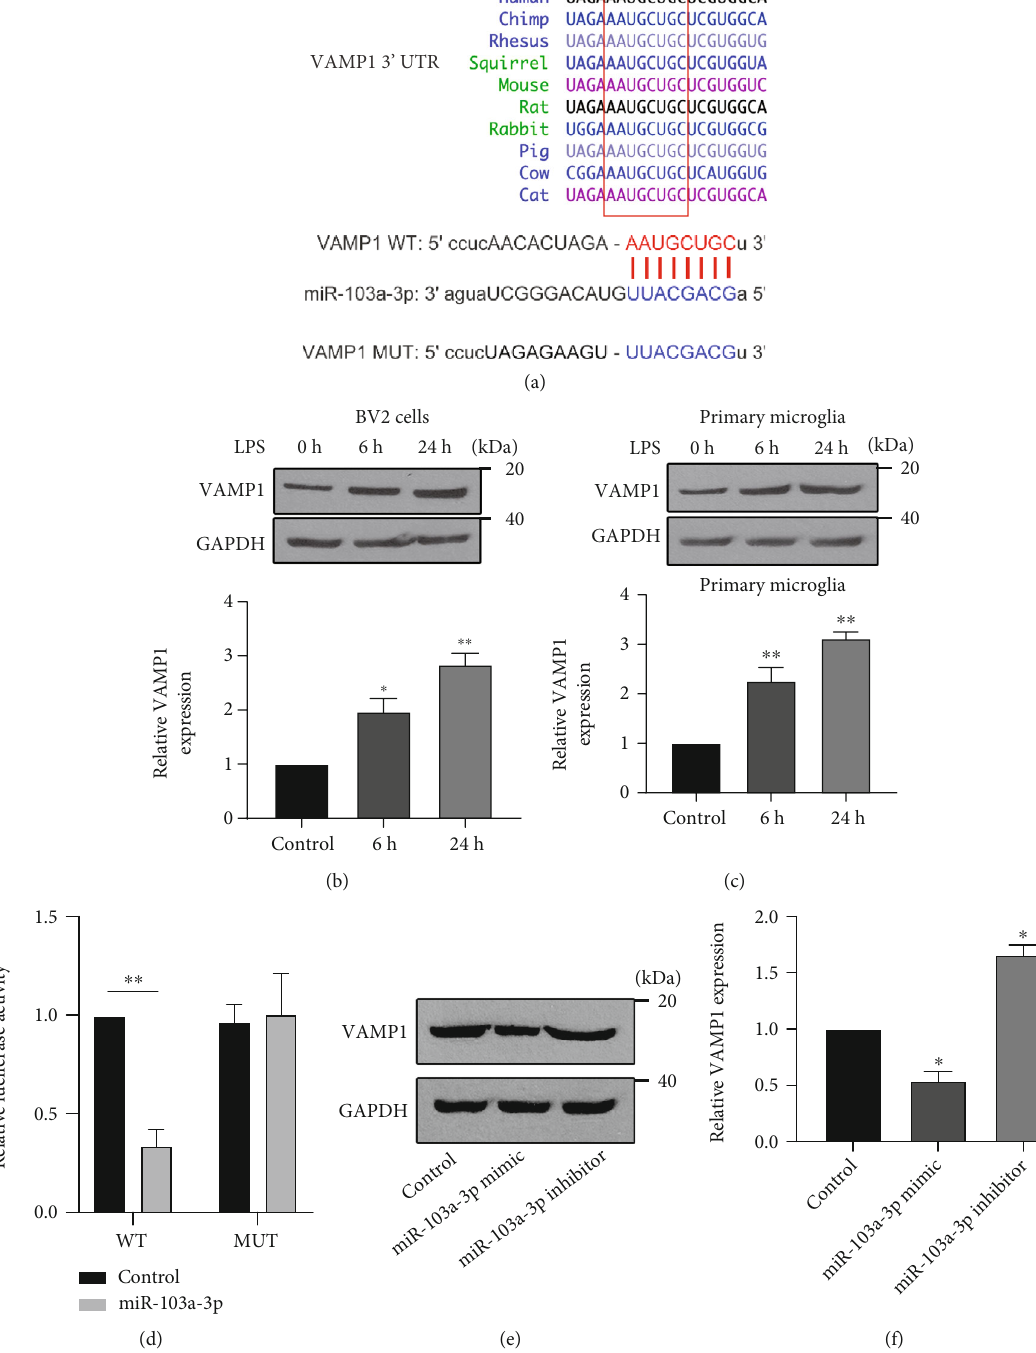
Figure 3: VAMP1 is a direct target of miR-103a-3p. (a) The target site of VAMP1 3 ′ -UTR from di ff erent species is shown. VAMP1 WT and MUT luciferase reporter plasmids were constructed. Protein expression levels of VAMP1 after LPS treatment for 6 h and 24 h (0 h as control), and statistical data, are shown for BV-2 cells (b) and primary microglia (c). (d) VAMP1 luciferase reporter plasmids were co- transfected with miR-103a-3p mimic or control (mimic NC sequence). Luciferase activity was measured in cultured BV-2 cells. (e) Protein expression levels of VAMP1 were determined by western blotting of extracts from BV-2 cells transfected with miR-103a-3p mimic or inhibitor (mimic and inhibitor NC as controls) ( n =3, number of repeated experiments). ANOVA ((b), (c), and (f)) and two tailed t -test, ∗ p < 0 : 05 , ∗∗ p < 0 : 01